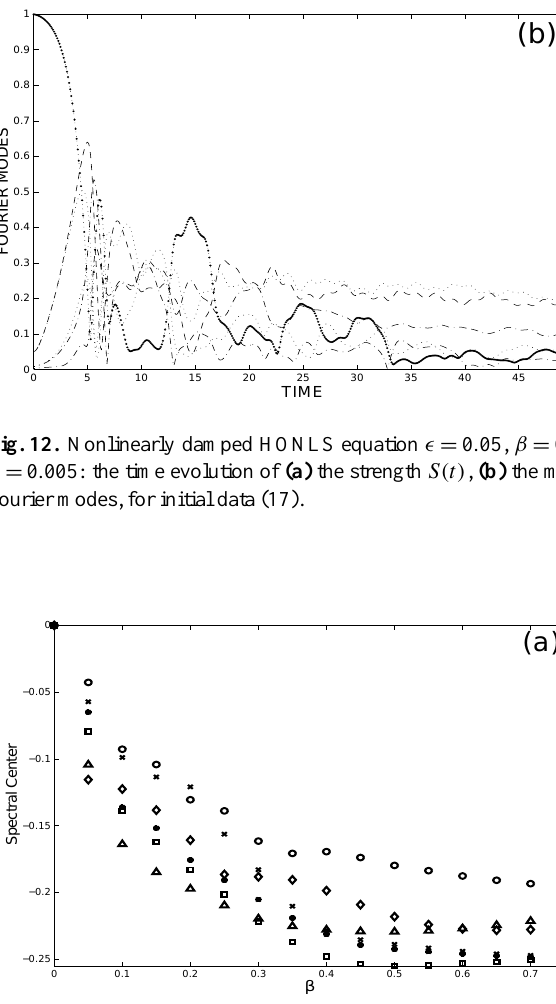
Fig. 12: Nonlinearly damped HONLS eq. ǫ = 0 . 05 , β = 0 . 5 , Γ = 0 . 005 : the time evolution of (a) the strength S ( t ) , (b) the main Fourier modes, for initial data (17).